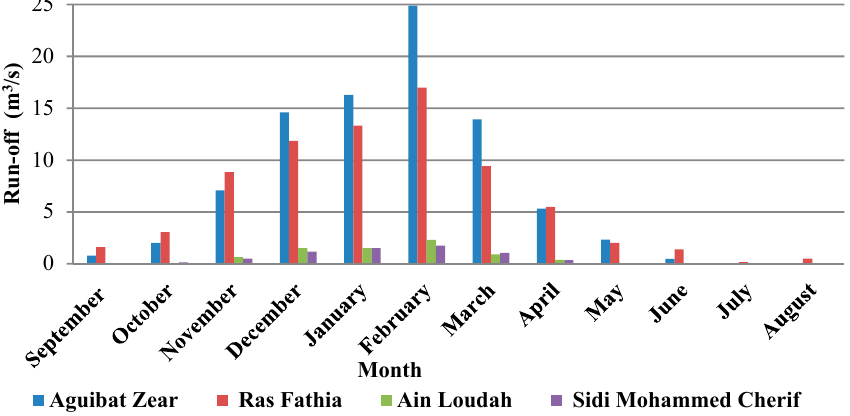
Figure 2. Annual discharges at the 4 hydrological stations studied.